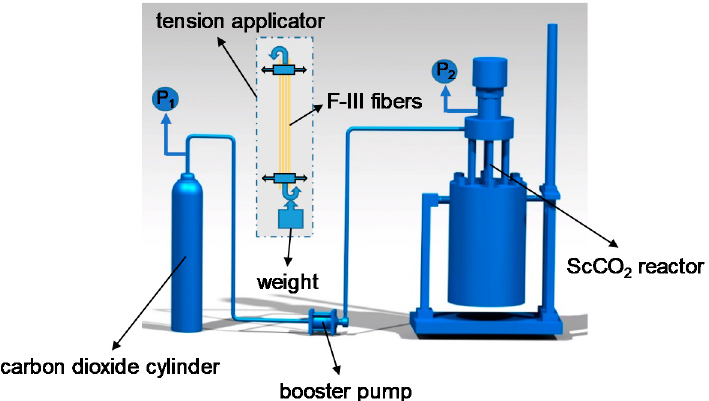
Figure 2. Schematic diagram of hot-drawing process of F-III fibers in the supercritical carbon dioxide (Sc-CO 2 ) reactor.